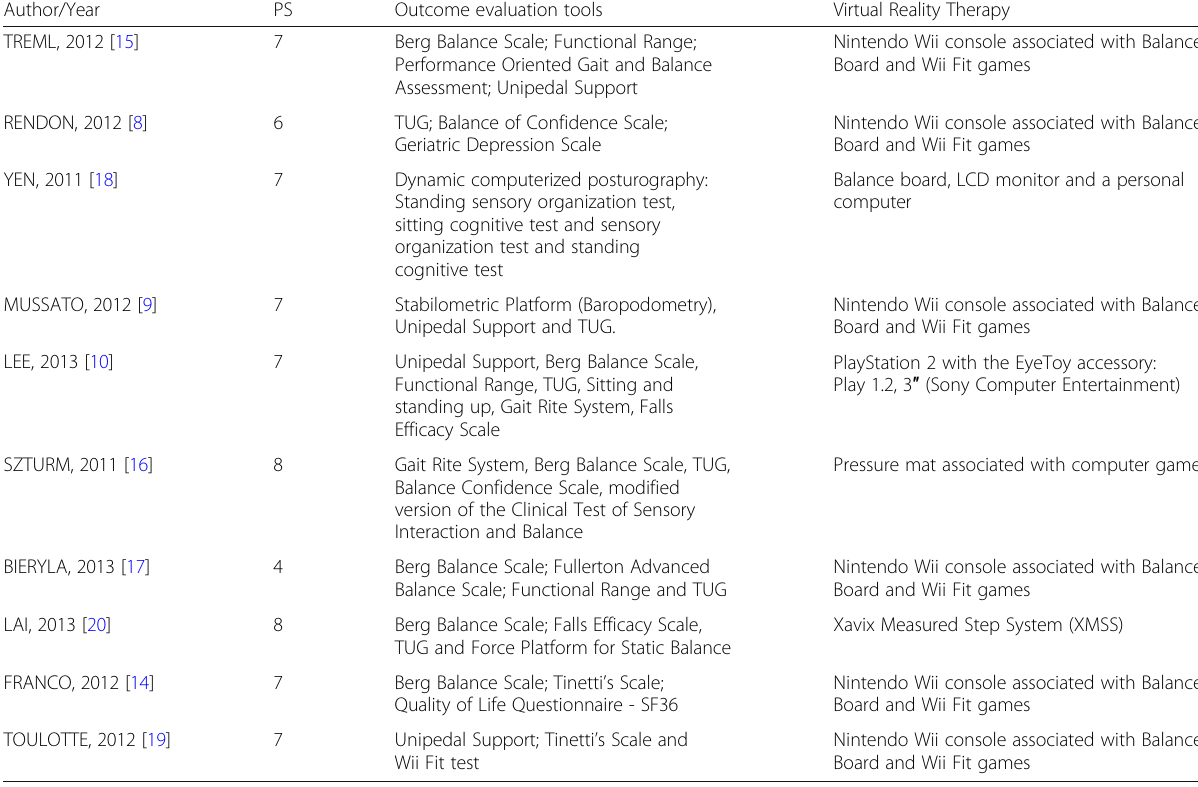
Table 2 Studies included in the systematic review: analysis of the methodological quality, instruments and equipment to perform the